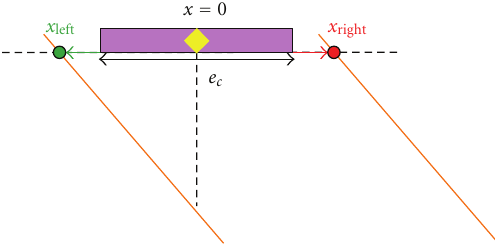
Figure 13: Ratio calculation by taking into account shadows. Case A